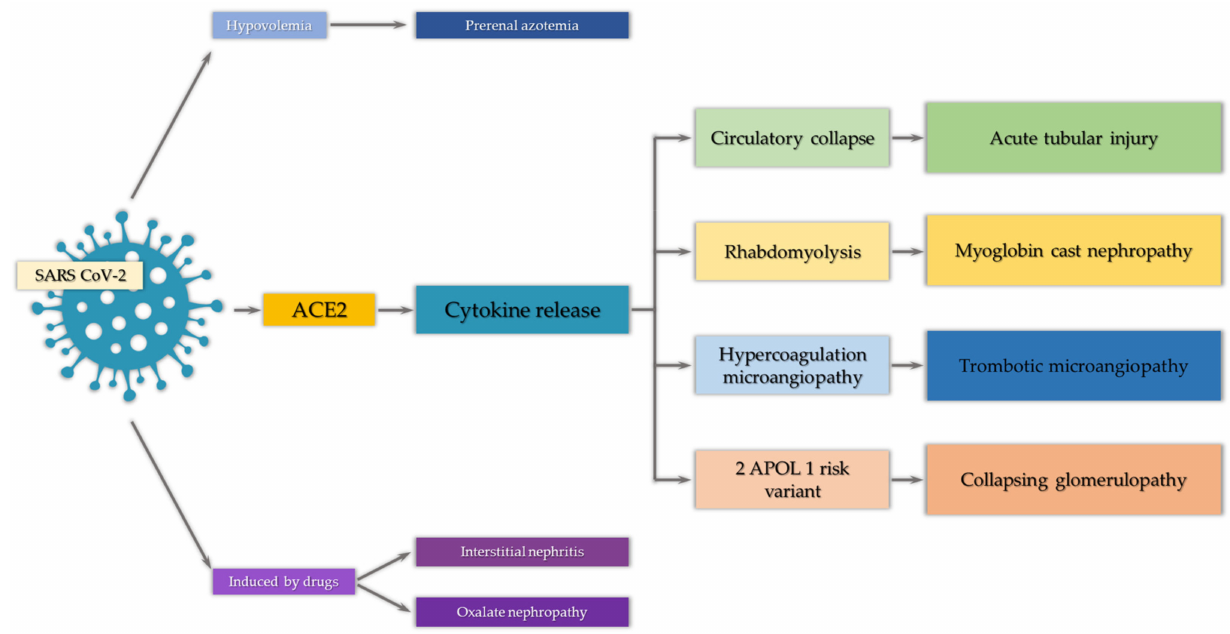
Figure 2. The summary of COVID-related AKI. SARS CoV-2, severe acute respiratory syndrome coronavirus 2; ACE2, angiotensin-converting enzyme 2; APOL1, apolipoprotein